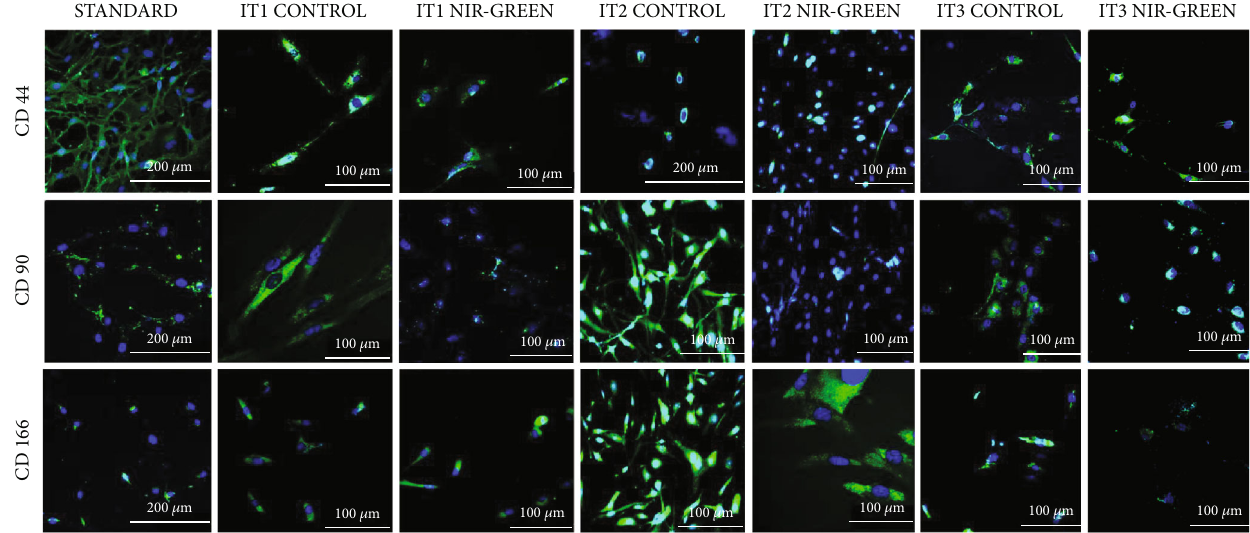
Figure 2: Characterization of di ff erentiated iADSCs using CD44, CD90, and CD166 markers. Fluorescent protein detection through fl uorescent microscopy. Fluorescent microscopy revealed the presence of SC markers 7 days post-PBM. Scale bar: 100 μ m. STANDARD CONTROL NIR-GREEN NIR-GREEN NIR-GREENCONTROL CONTROL B05IT1NIR-GREENNeuN Gate:(UNSTAINEDinCELLS) and(STANDARD)